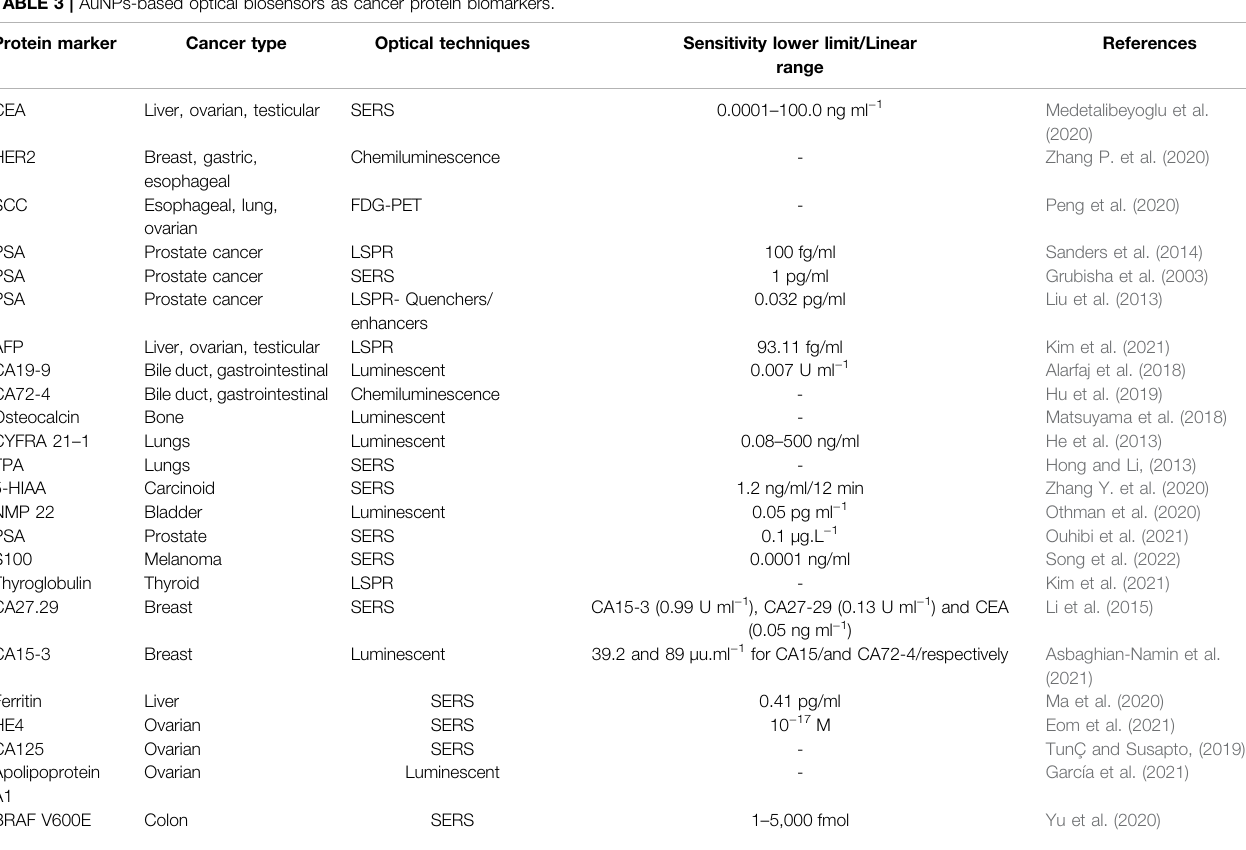
TABLE 3 | AuNPs-based optical biosensors as cancer protein biomarkers. Protein